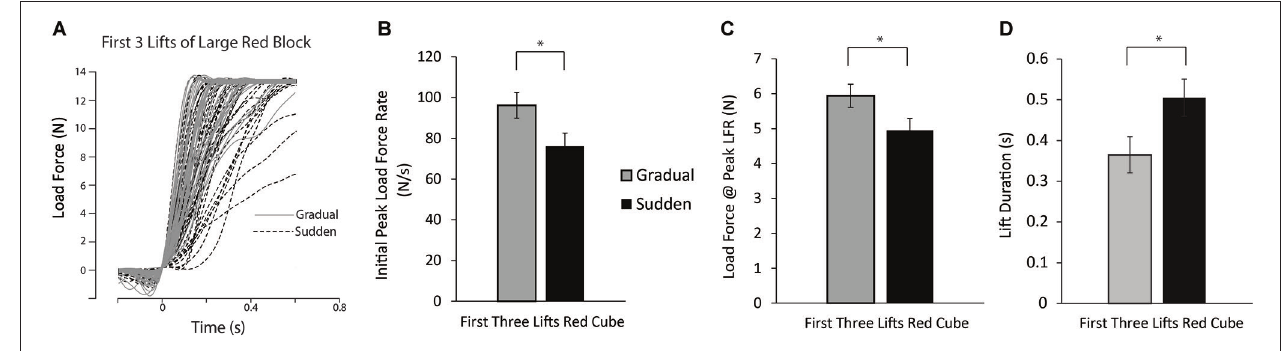
initial PeakLFR (B) , load force at initial peak in load force rate (C) , and LPD (D) averaged across participants. Vertical lines represent ± 1 standard error, asterisk denotes statistical significance at the p < 0.05 level.